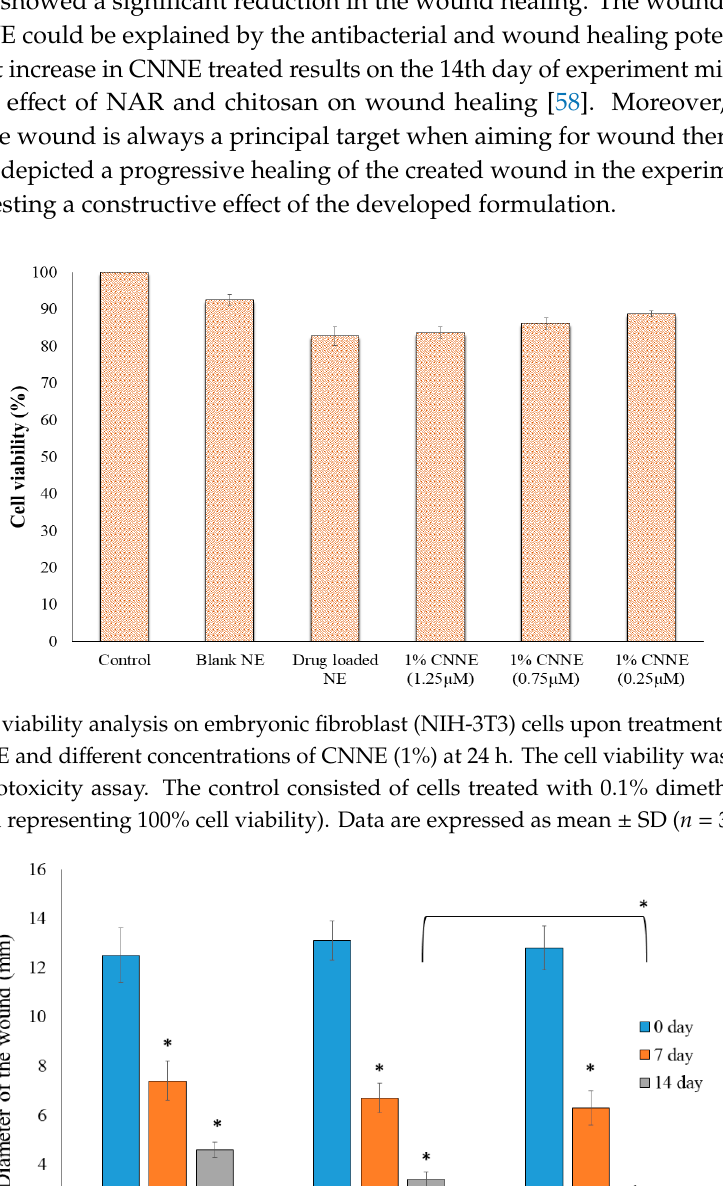
Figure 12. Representative photographic images of wound areas in control, drug-free chitosan-coated NE formulation, and CNNE (1%) treated Wistar rats on days 0 and 14. 3.11. Histopathological Assay The microscopic examination of the tissues aids in diagnosing the condition of the cells pertaining to management of the patient. The photomicrographs (Figure 13A, 0 day) of rat tissue sections (100 µm/100×) stained with H & E correspond to the negative control rat skin showing global granulation tissue formation and also having infiltration of inflammatory cells as active inflammatory response. Upon completion of the 14-day treatment period of the negative control treatment group, Figure 13B is showing a worsening pathology of increased global granulation tissue formation in dermis as active inflammatory response. In addition, subcutaneous tissue is showing focal suppuration, defected or changed normal flora to dermis. Alternatively, treatment of the second group animals with the blank formulation for 14 days is showing acanthosis into the dermis and infiltration of inflammatory cells into it (Figure 13C). Mild to moderate hyperkeratosis is also shown in the dermis. On the other hand, CNNE (1%) treated animals, after 14 days, are showing improved morphology with mild to moderate penetration of inflammatory cells infiltration into the dermis (Figure 13D). Overall, the migration of cells for effective healing of the wounds was found to be faster in CNNE (1%) treated animals compared to the control, and blank formulation treated animals, suggesting superiority of our formulation approach towards wound healing.